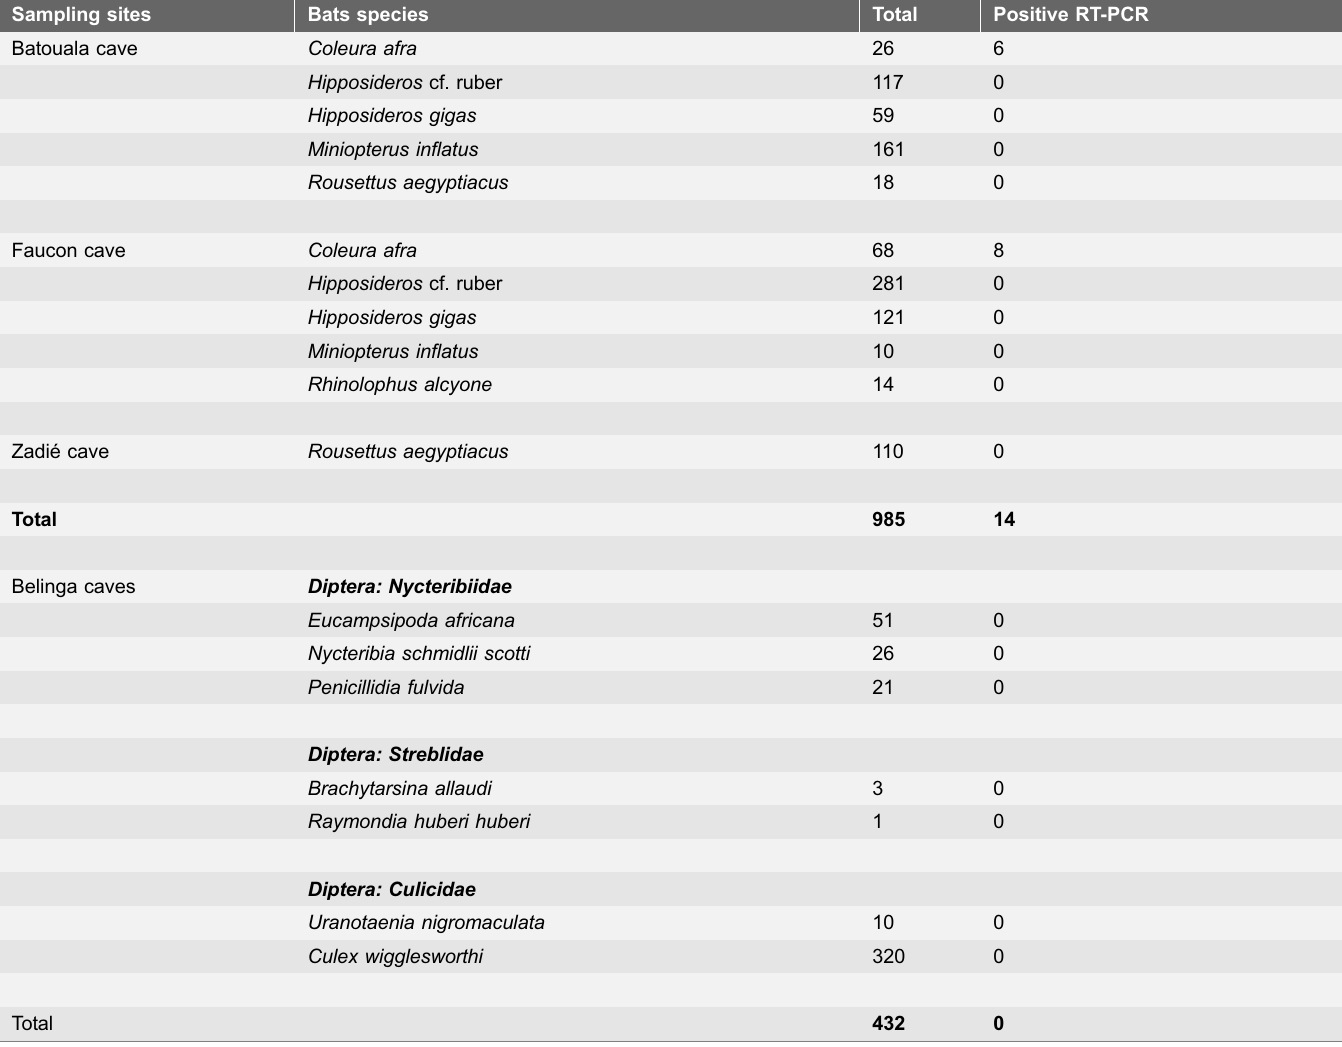
Table 1. Overview of specimens collected in Belinga caves and tested by specific BelPV qPCR assay. Sampling